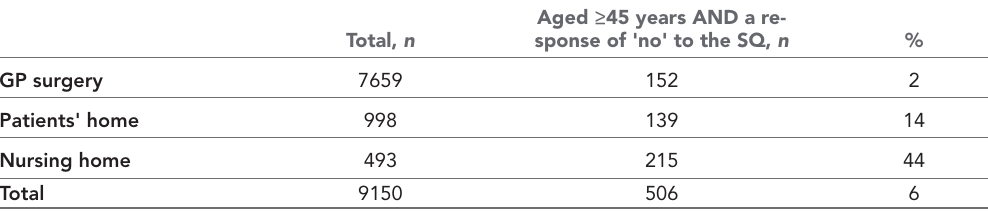
Table 3 Distribution of patients eligible for early palliative care, per